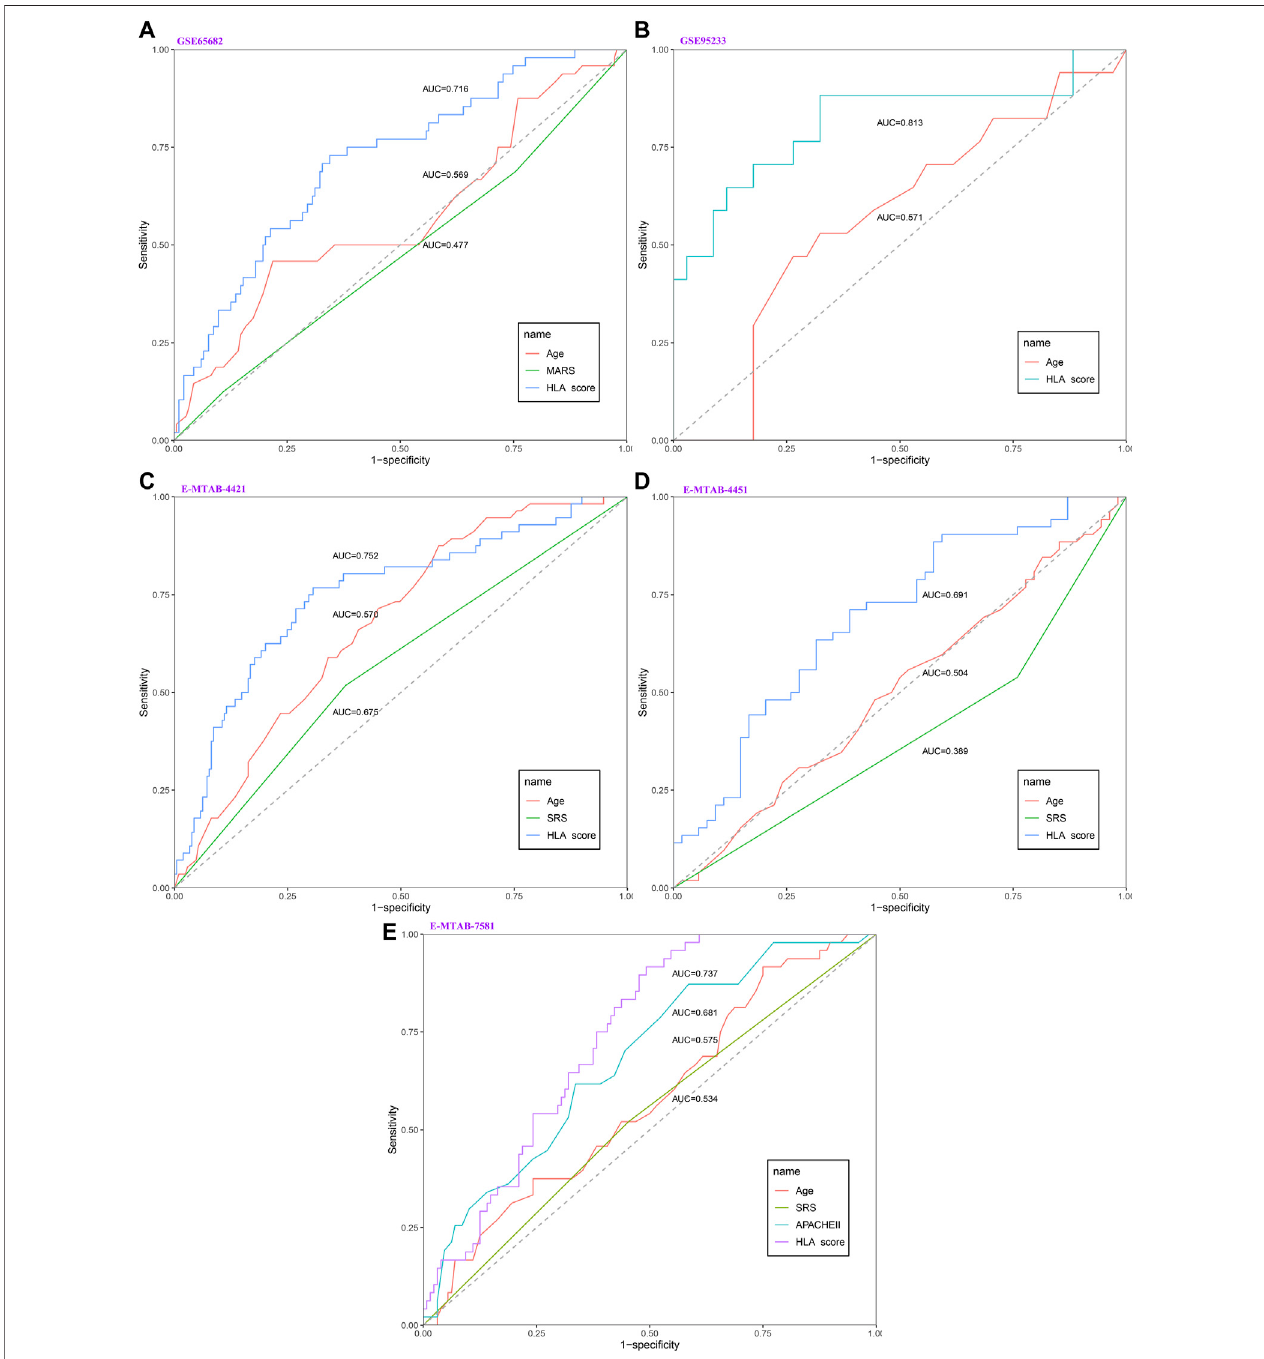
FIGURE 4 | The evaluation of the performance of the HLA classi fi er compared against age, SRS, MARS, and APACHE II in the discovery and external validation cohorts. (A) GSE65682 datasets. (B) GSE95233 datasets. (C) E-MTAB-4421 datasets. (D) E-MTAB-4451 datasets. (E) E-MTAB-7581 datasets.